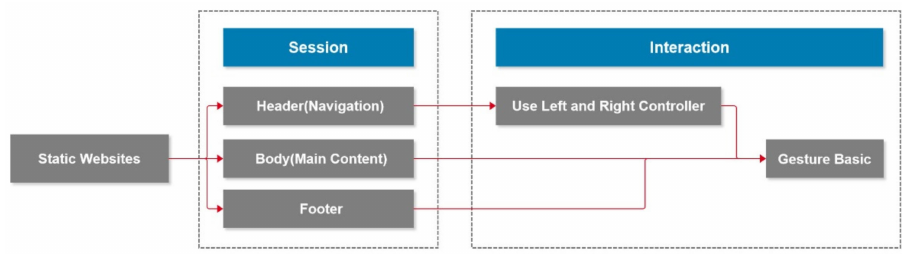
Figure 6. Gesture interaction concept for static